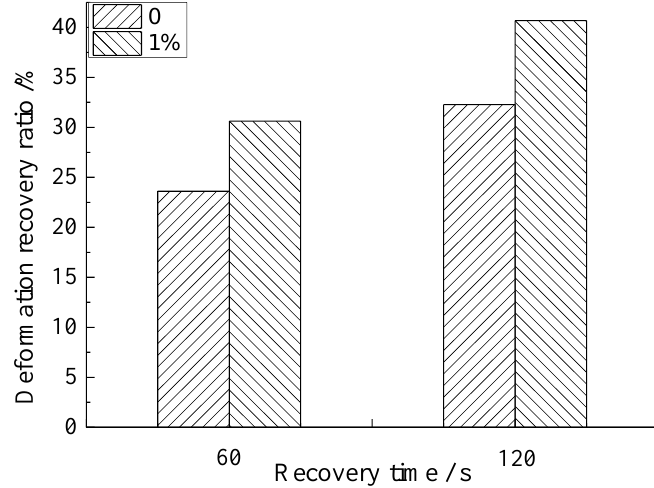
Figure 14. The deformation recovery ratio of the asphalt mixture and asphalt mixture mixed with the SM-HEP-AM.